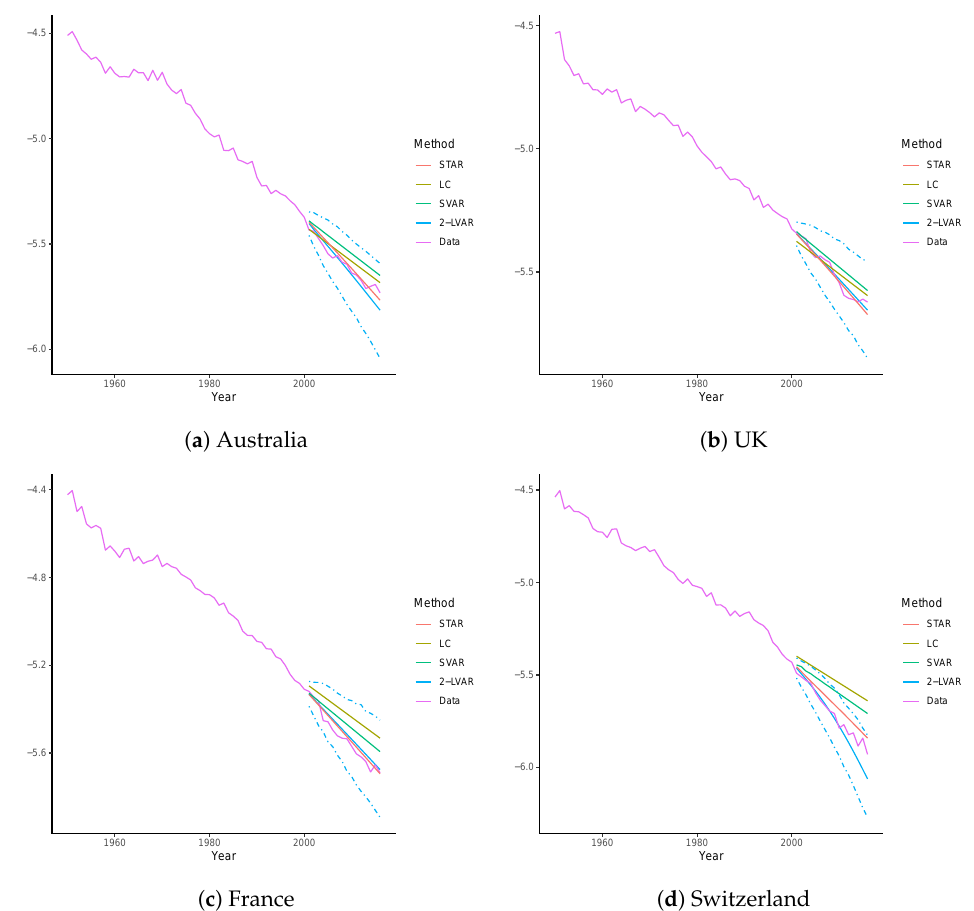
Figure 4. Forecast vs. actual mortality rates for mortality data of Australia, the UK, France, and Switzerland. The training sample includes 1950–2000, and the test sample includes 2001–2016. The compared models are LC, STAR, SVAR, and 2-LVAR. Presented curves are rates averaged across ages 0–100 for each model or the actual dataset. Dashed lines are the corresponding 95%